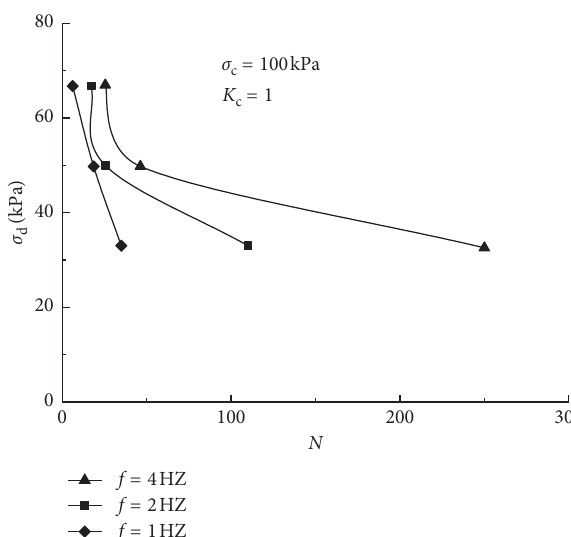
Figure 11: Dynamic strength curves of clay under different vi- bration